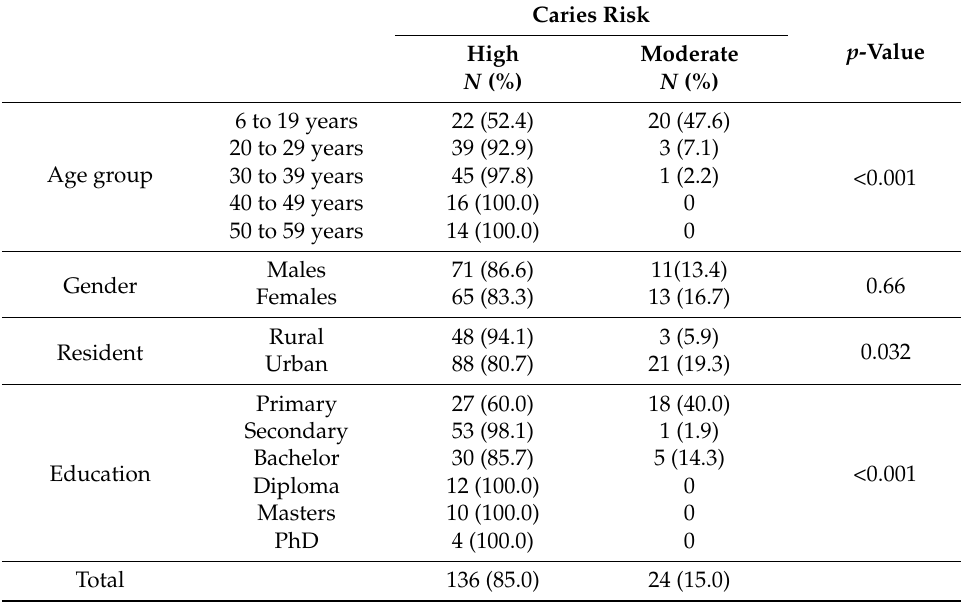
Table 3. Socio-demographic characteristics-wise comparison of caries